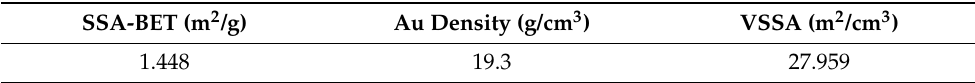
Table 5. SSA and VSSA of the dried AuNPs in a PVP matrix.